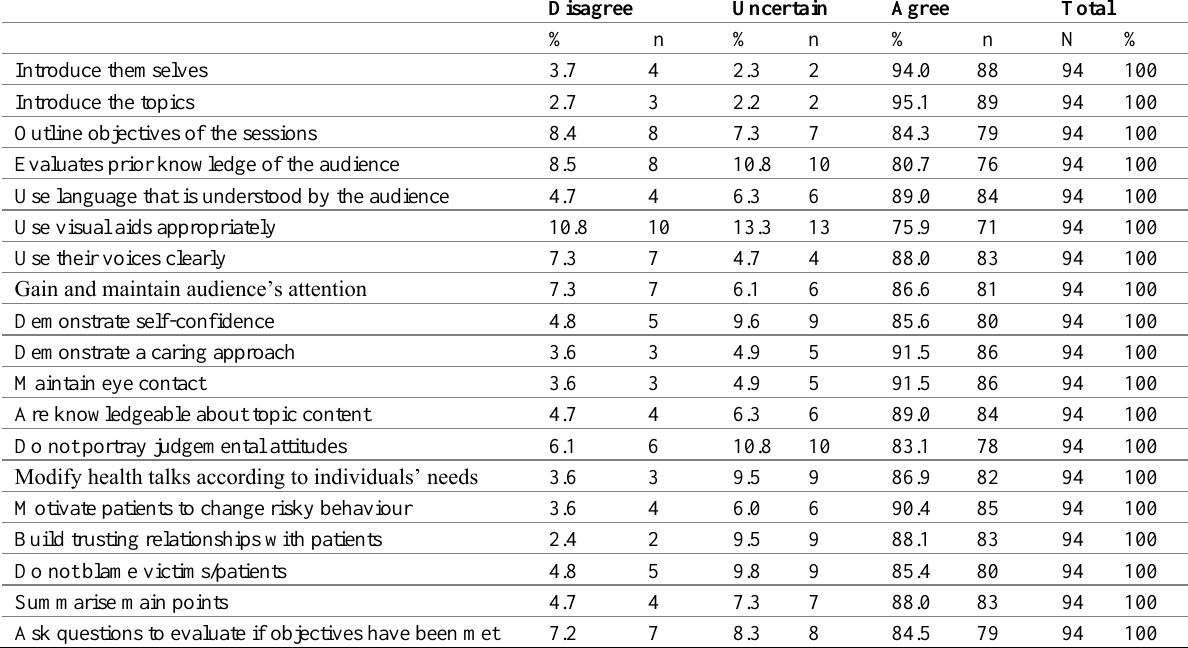
Table 3: Implementation of health education